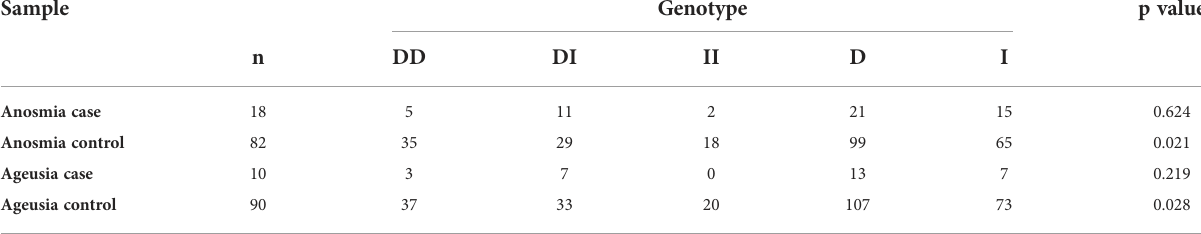
TABLE 2 Genotypic and allelic absolute values for the rs4646994 polymorphism.